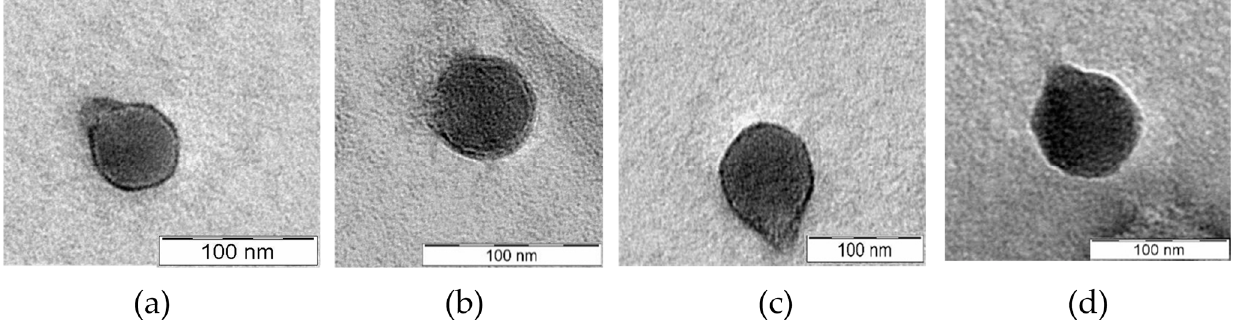
Figure 4. Electron microscopy images of negatively stained phage particles. Scale bar represents 100 nm. ( a ) PRF-SP1, ( b ) PRF-SP3, ( c ) PRF-SP4, ( d ) PRF-SP5.